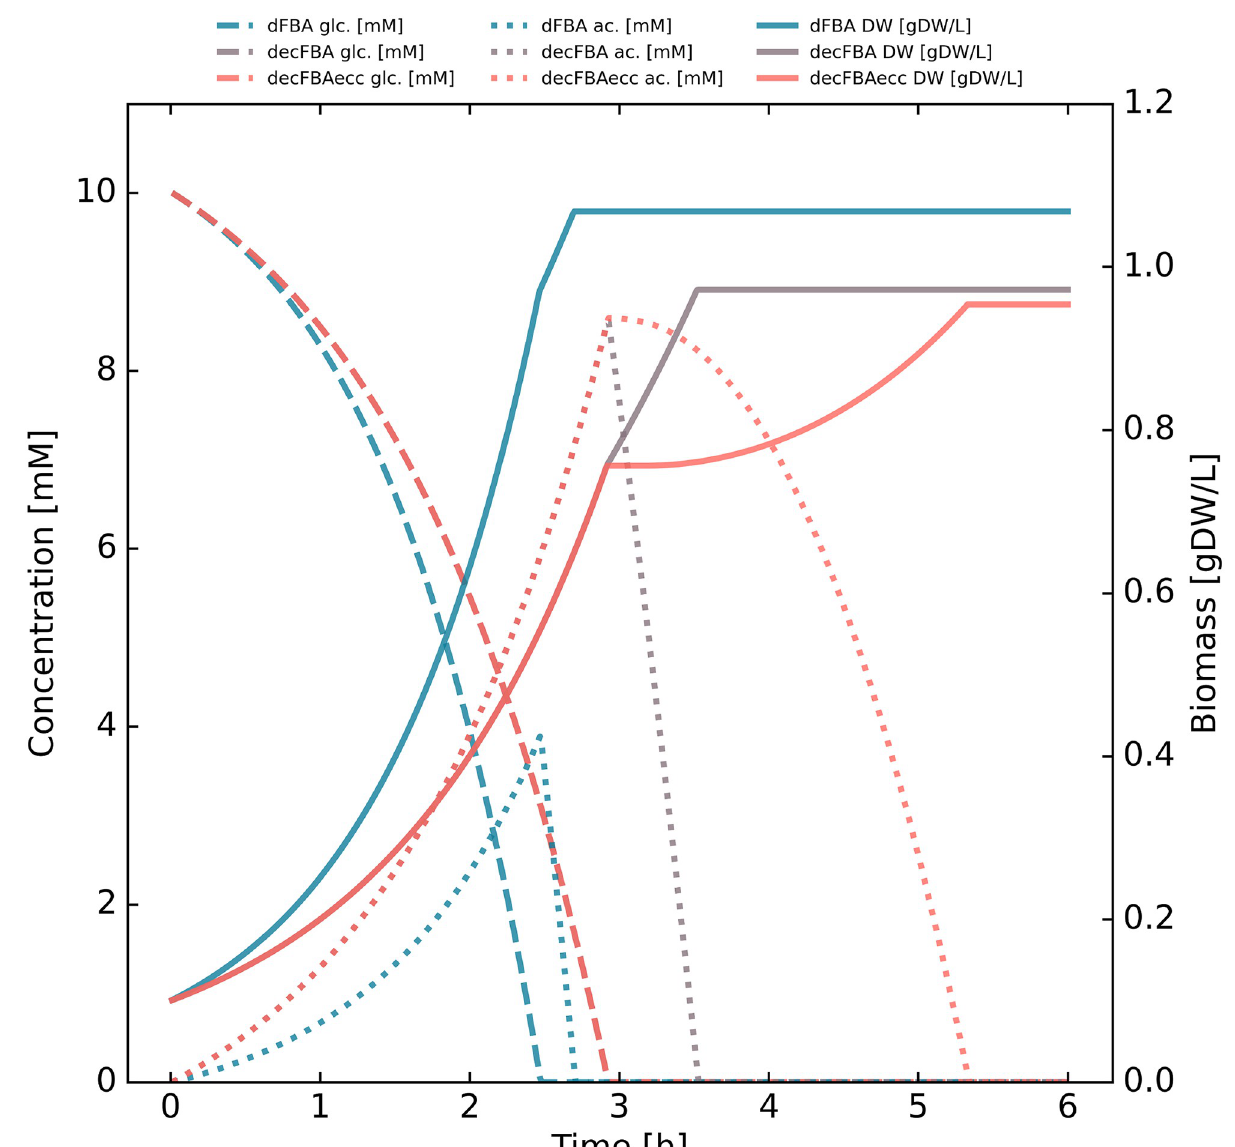
Fig 1. Transitioning from standard dFBA to decFBAecc. Shown in the figure are glucose (glc), acetate (ac) and biomass (DW) concentrations for dFBA, decFBA, and decFBAecc. Most reactions are unconstrained, but glucose uptake is limited to 10.5 mmol gCDW − 1 h − 1 , and oxygen uptake is limited to 15 mmol gCDW − 1 h − 1 . In the dFBA case, the i JO1366 � model has been adjusted with an arbitrarily large protein pool constraint (5000 g gCDW − 1 of enzyme, which allows every flux to reach 1000 mmol gCDW − 1 h − 1 ) to produce standard dFBA results; glucose is rapidly depleted, while acetate is accumulated before being rapidly depleted as well. In the decFBA case, the i JO1366 � model is simulated without modifying the protein pool constraint (0.0948 g gCDW − 1 of enzyme), allowing slightly slower growth; glucose is depleted slower than in the dFBA case, and more acetate accumulates before being depleted at a similar rate. In the decFBAecc case, the protein pool constraint is the same as default setting, but the rate at which the enzyme composition is allowed to change has been limited to 1% per hour (as opposed to being instantaneous); the trajectories are identical until the metabolism shifts from growth on glucose to growth on acetate, at which point there is a short lag